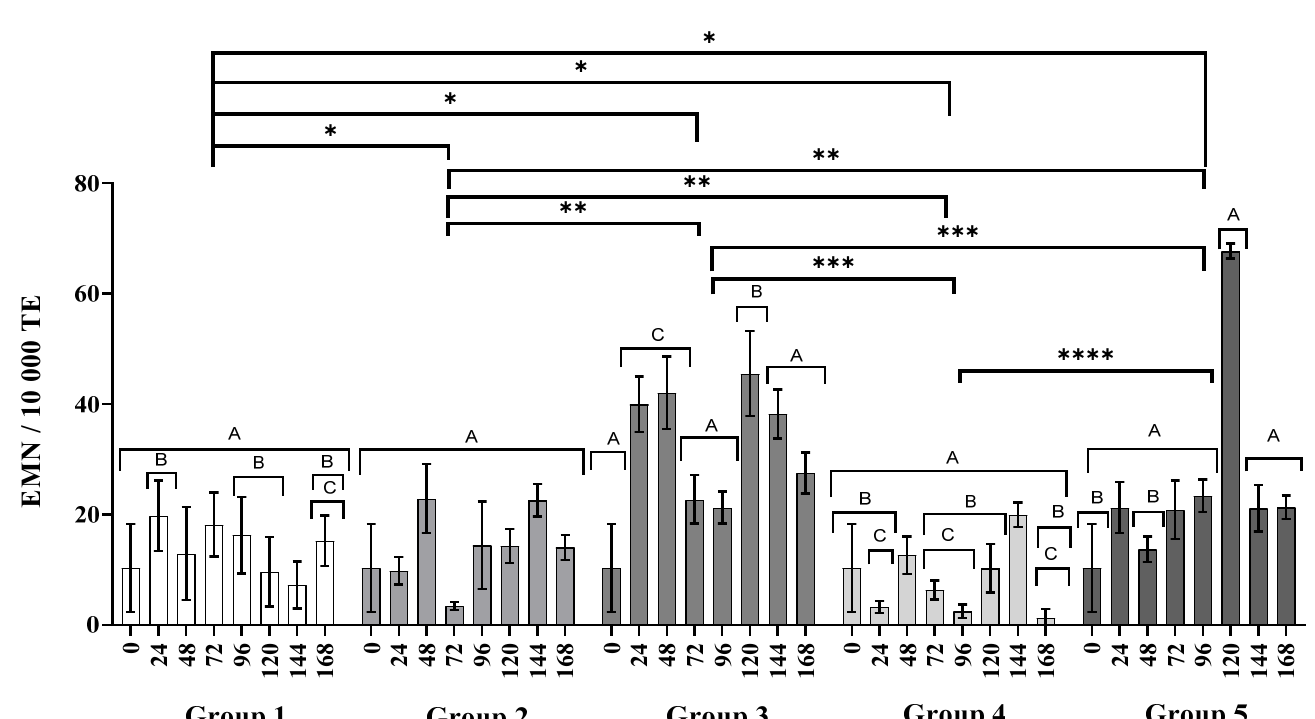
Figure 5. Micronucleated erythrocytes observed in 10,000 total erythrocytes. Group 1: water (0, 24, 48 h), Group 2: CP (0 h), Group 3: AgNPs (0, 24, 48 h), Group 4: CP+ AgNPs; CP (0 h) + AgNPs (24, 48, 72 h), and Group 5: CP +AgNPs; CP (0, 48, 96 h) + AgNPs (24, 72, 120 h). *, **, ***, and **** denote statistically significant differences between groups ( p < 0.0001); letters A–C denote statistically significant differences ( p > 0.0001) between inter and intragroup concentrations ( p < 0.0001). Numeric data used to build the graph can be consulted in Table S3.